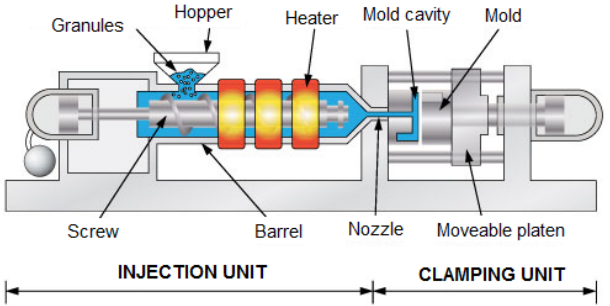
Figure 1. Simple schematic of injection molding